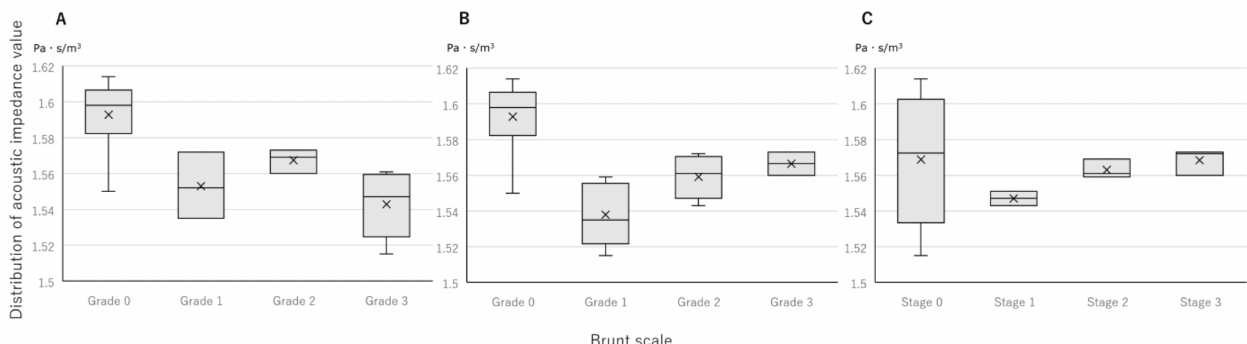
Figure 3. Distribution of acoustic impedance values in the control group and in mice with steatohepatitis based on pathohistologic evaluation of the liver, according to the Brunt system. ( A ) Steatosis grade (0; n = 6, 1; n = 3, 2; n = 3, 3; n = 6). ( B ) Inflammation grade (0; n = 6, 1; n = 5, 2; n = 5, 3; n = 2). ( C ) Fibrosis stage (0; n = 10, 1; n = 2, 2; n = 3, 3; n =